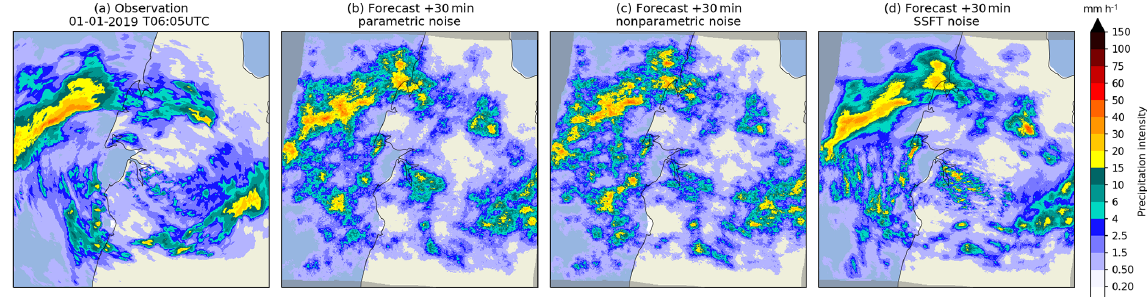
Figure 3. Comparison of three + 30min stochastic nowcasts produced with the FFT noise generators available in pysteps as described in Sect. 2.6. (a) The radar-based rainfall analysis from the Australian radar network valid at 06:05UTC on 1 January 2019 on a 512 × 512 pixel grid (event no. 2 in Table 10). (b) – (d) One member of a + 30min nowcast produced using (b) the parametric noise generator, (c) the non-parametric generator or (d) the short-space Fourier transform (SSFT) generator with a 128 × 128 pixel sliding window. All realizations share the same random